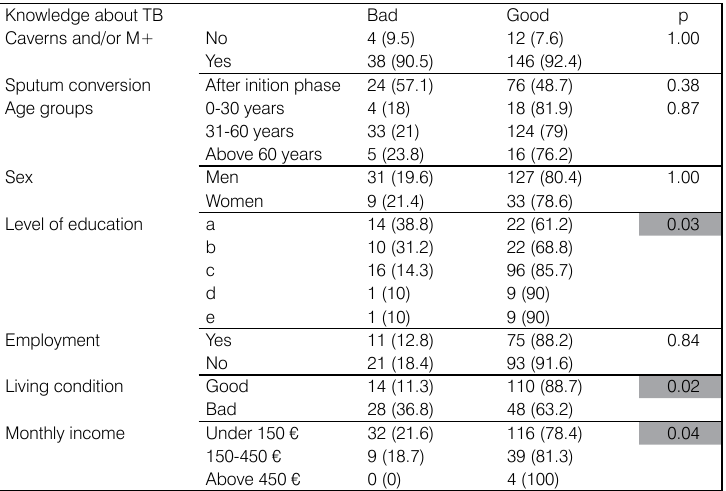
Table 4. Comparison between knowledge about TB to parameters (severity of diseases, conversion of sputum, age groups, sex, education, financial, employment, living condition) to (n, %,